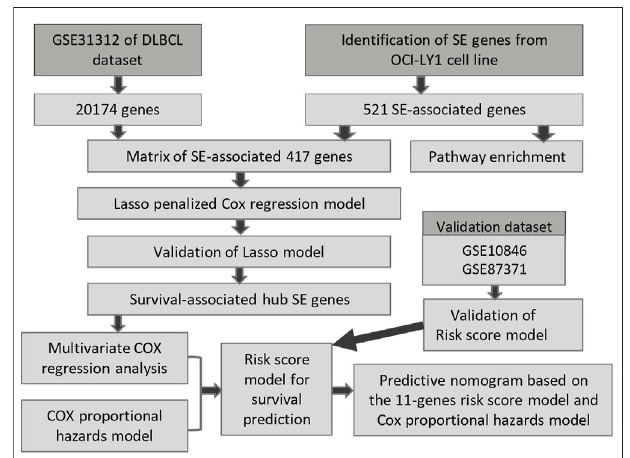
FIGURE 1 | The procedure work fl ow used to establish and certify the SE-associated gene-based prognostic model for patients with diffuse large B-cell